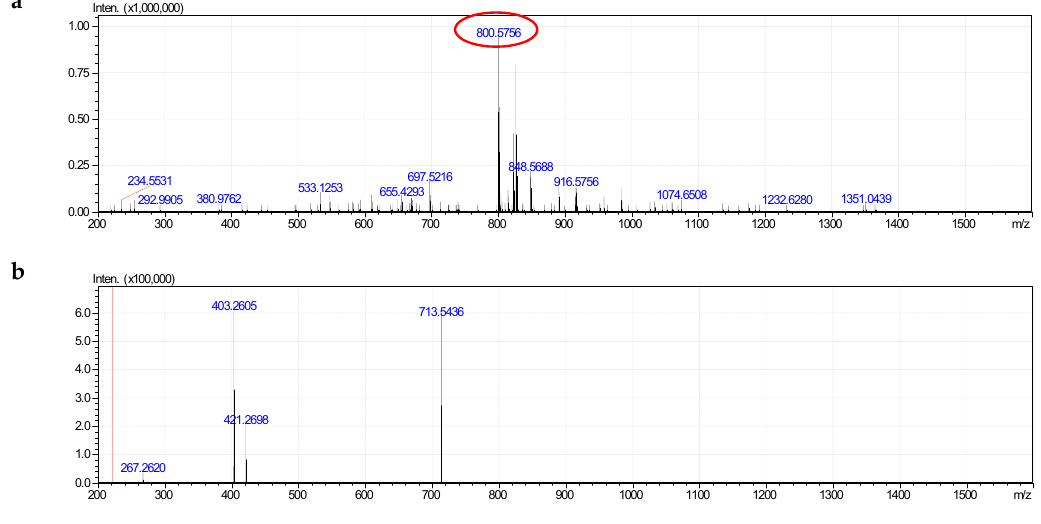
Figure 5. Fragmentation of PS (38:1): a —MS − , b —MS 2 − .